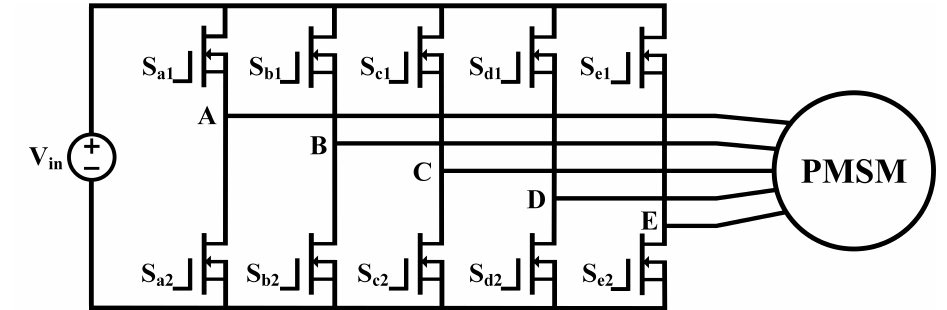
Figure 4. Schematic of five-phase single-turn motor driver